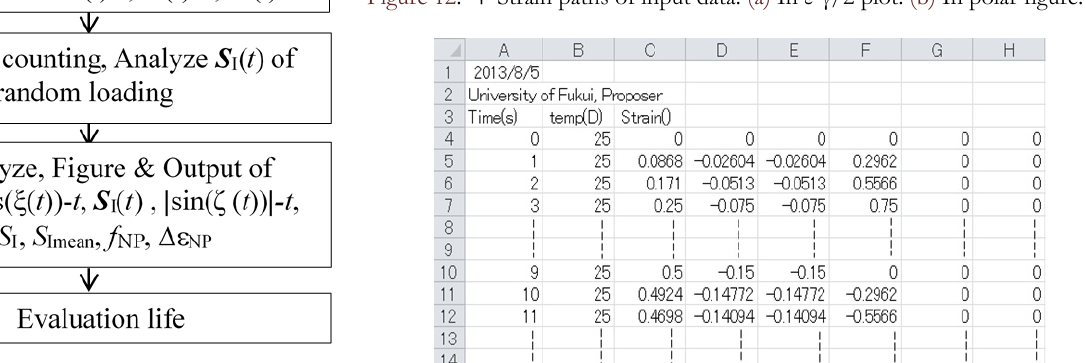
Figure 12: 4 Strain paths of input data: (a) In ε - γ /2 plot. (b) In polar figure.